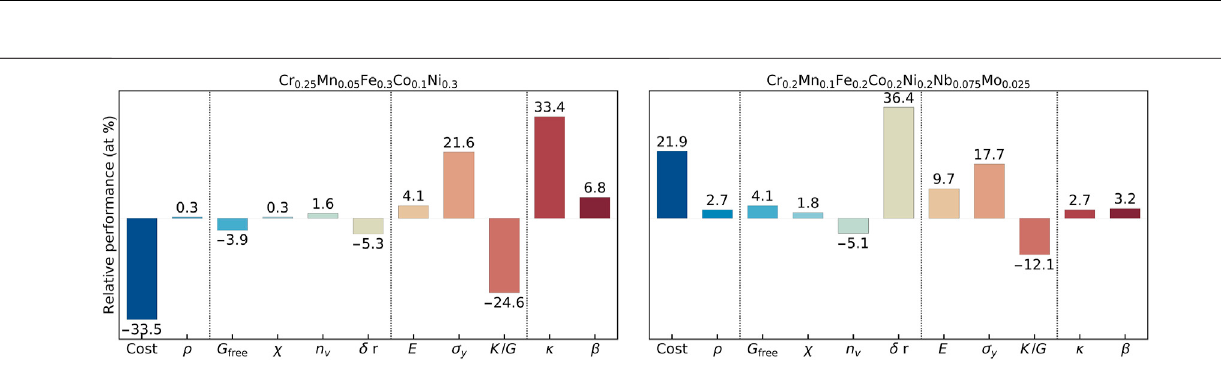
Frontiers in Materials |